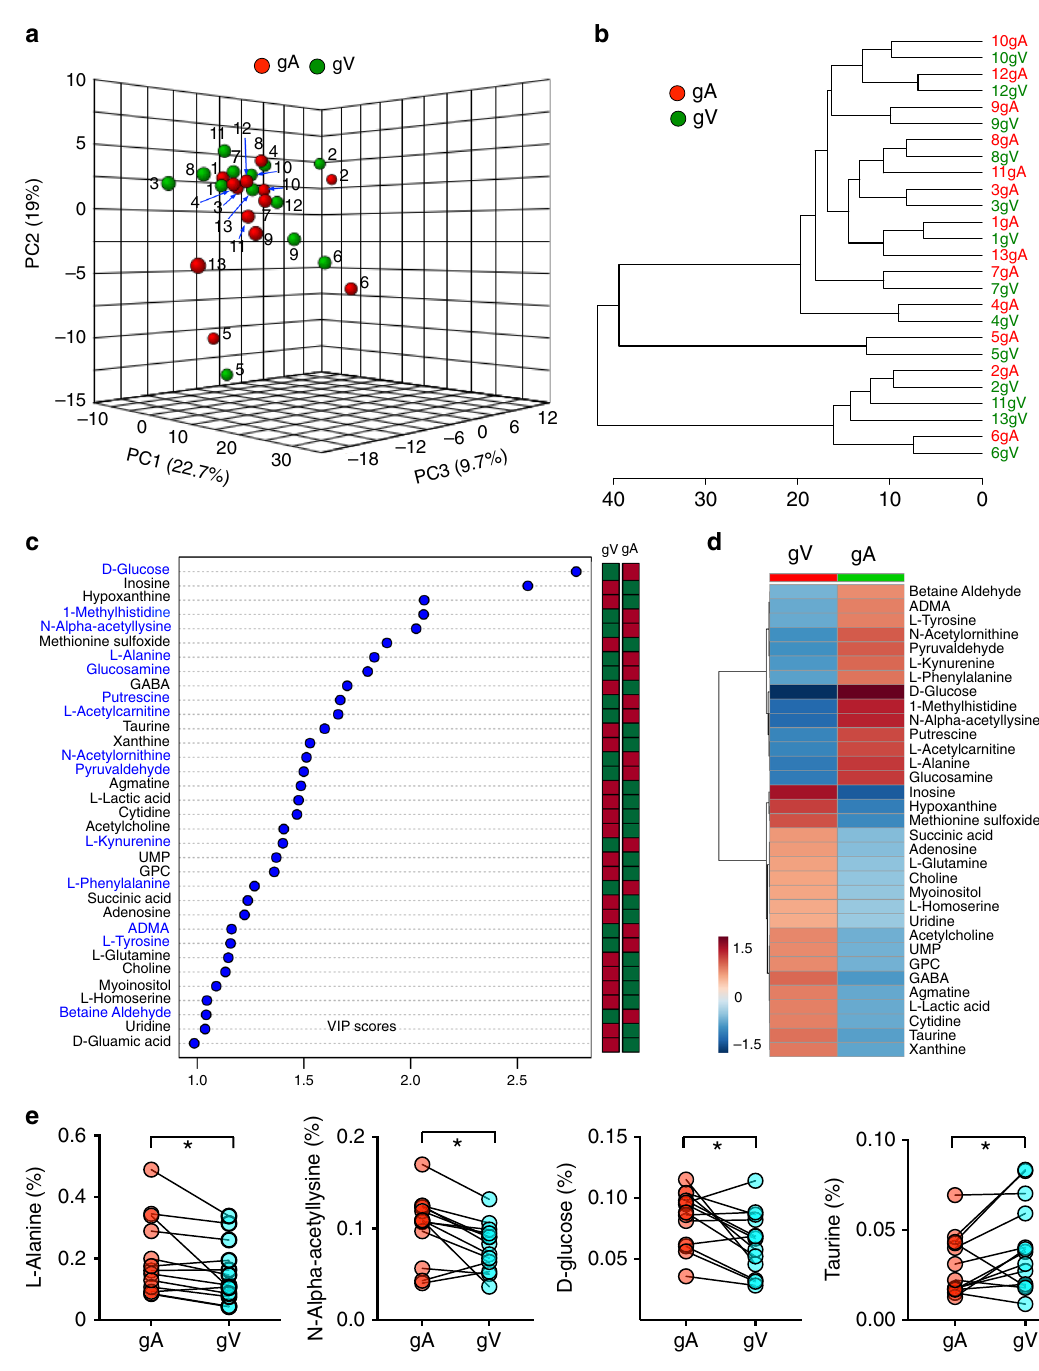
Fig. 2 Paired comparison of metabolomes from glioma arterial and venous plasma. a PCA of the 107 metabolomes of glioma arterial and glioma venous samples from 13 patients. The top three PCs explain 51.4% (19%, 22.7%, and 9.7%) of the total variance. Each circles indicate an individual sample of patient arterial or venous blood. gA (samples from glioma arteries, red) and gV (samples from glioma veins, green) cannot be separately by the unsupervised PCA. b Clustering analysis of the metabolomic data from 13 patients. c VIP scores of metabolites by PLS-DA. The names of metabolites enriched in glioma arterial plasma (gA) are labeled blue. The columns to the right indicate whether the abundance of each metabolite is enhanced (red) or reduced (green) in the arterial or venous plasma group. d Heatmap of metabolites levels with VIP score > 1. Color bar (bottom left) indicates the scale of standardized metabolite levels. Warm color indicates higher concentration. e Relative abundance (normalized by TIC, Total Ion Chromatogram, y -axis) of four representative metabolites (L-alanine, N-alpha-acetyllysine, D-glucose, and Taurine) from arterial (gA) and venous (gV) samples. * p < 0.05 ; two-tailed paired t -test. GPC, Glycerophosphocholine. GABA, Gamma-Aminobutyric acid. UMP, Uridine